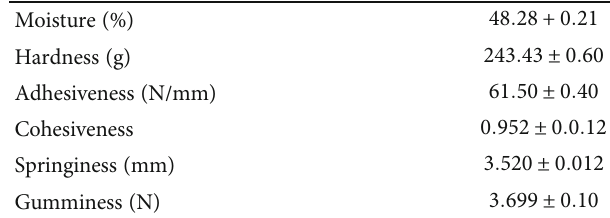
Table 3: Texture analysis of